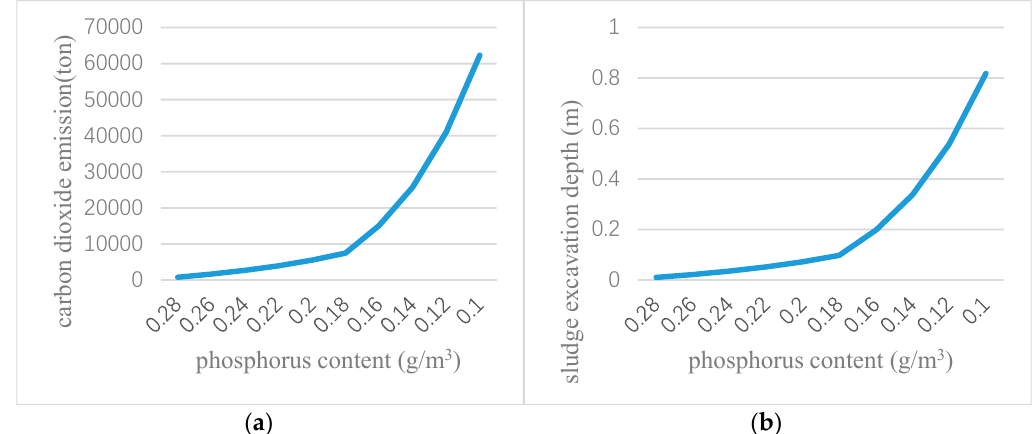
Figure 2. Relationship between phosphorus content and carbon dioxide emission ( a ) and dredging depth ( b ).